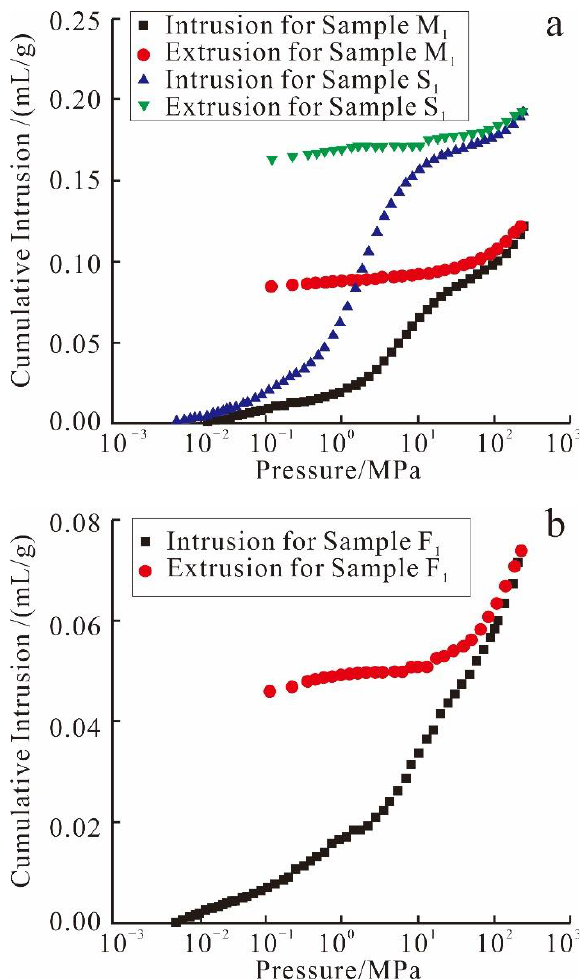
Figure 1. Mercury intrusion curves for different samples. ( a )Sample M 1 & Sample S 1; ( b )Sample F 1